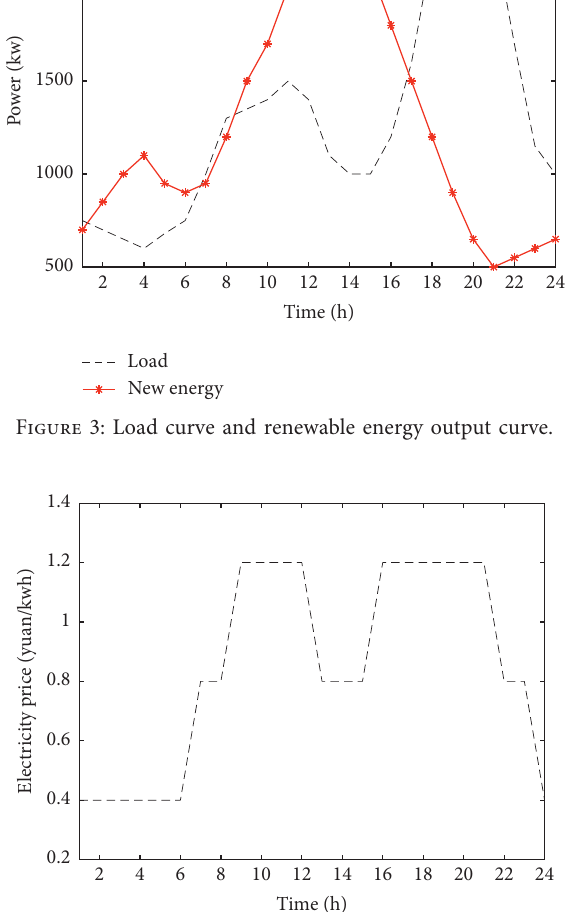
Figure 4: Electric TOU